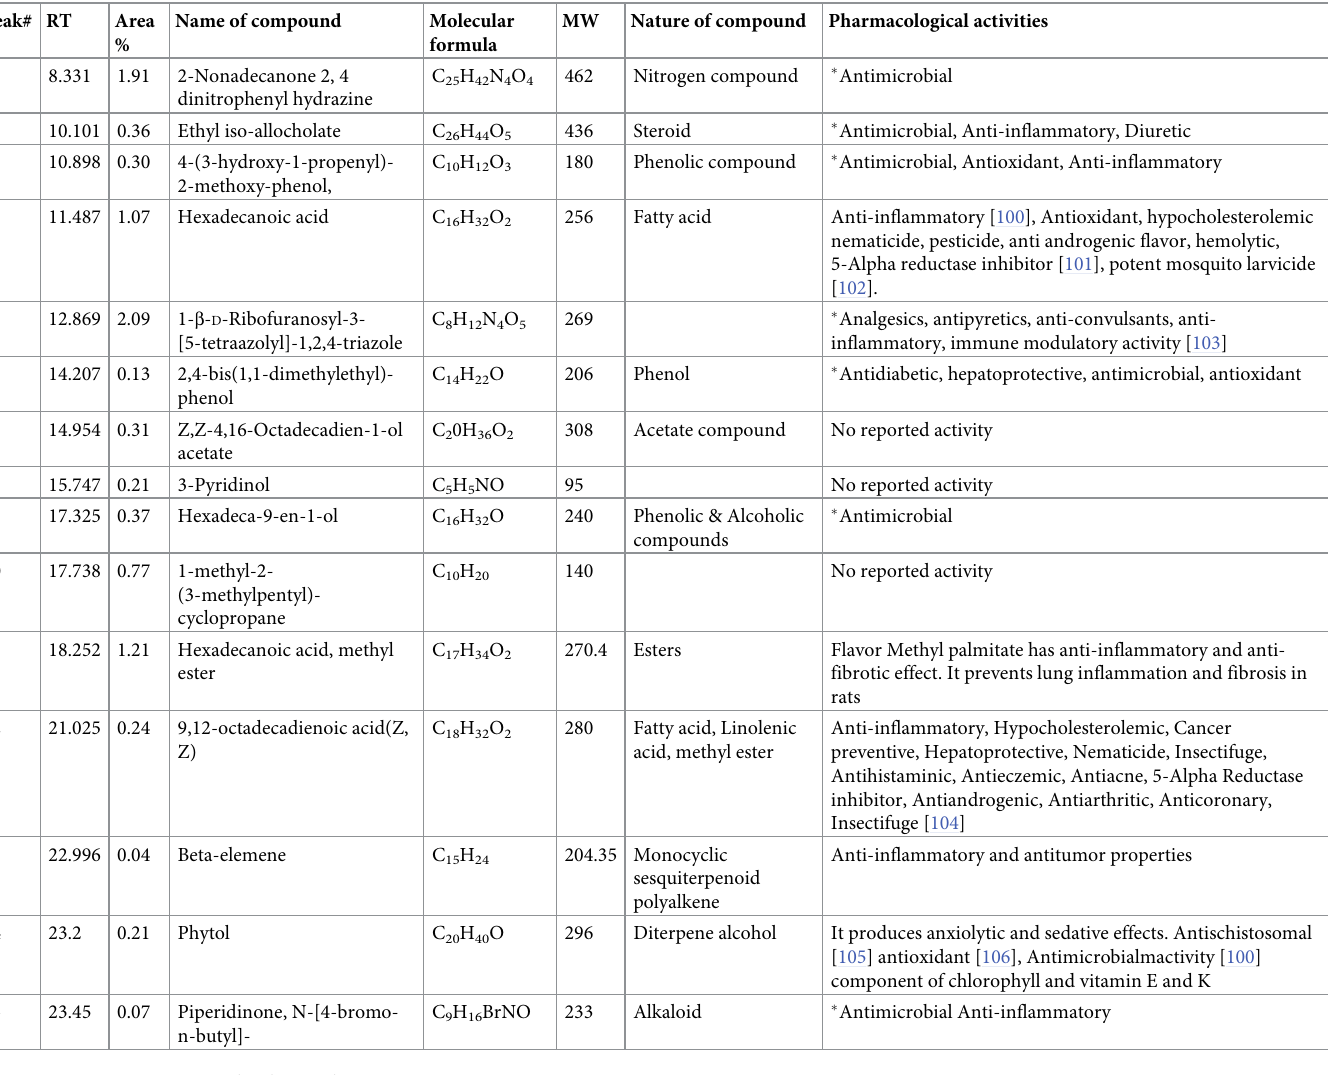
Table 8. Phytochemical compounds identified in the methanol leaf extracts of Jacaranda mimosifolia . Peak# RT Area